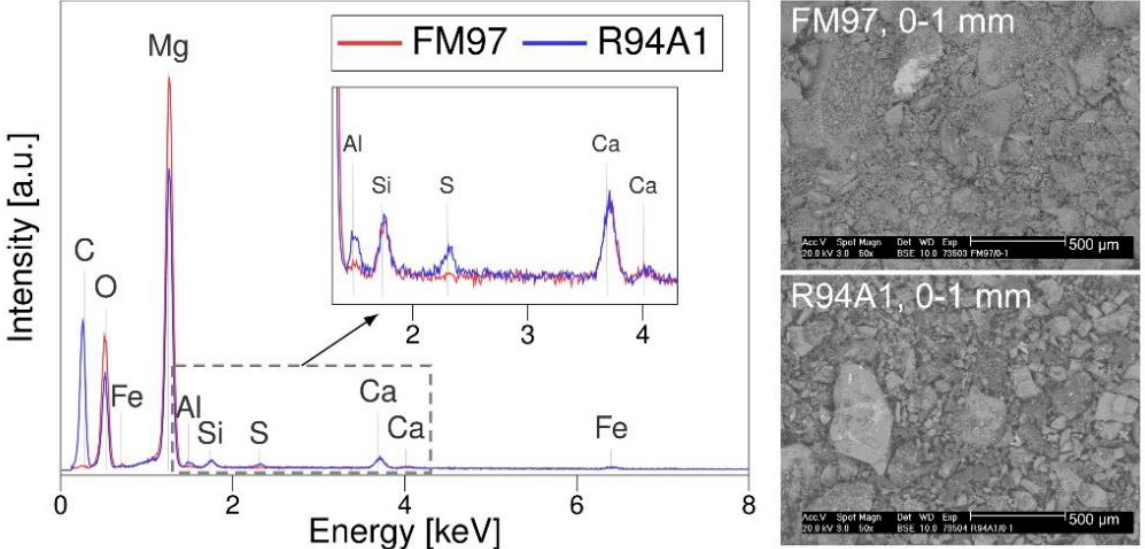
Figure 2. Results of EDS analysis of the 0–1 mm fraction of fused magnesia FM97 and MgO-C recyclate R94A1. The corresponding BSE micrographs of the analyzed samples can be seen on the right.